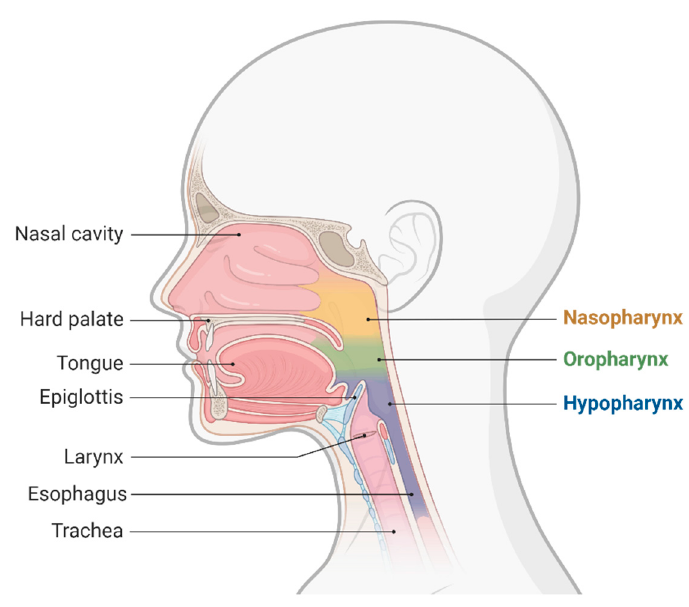
Figure 1. Upper airway anatomy.